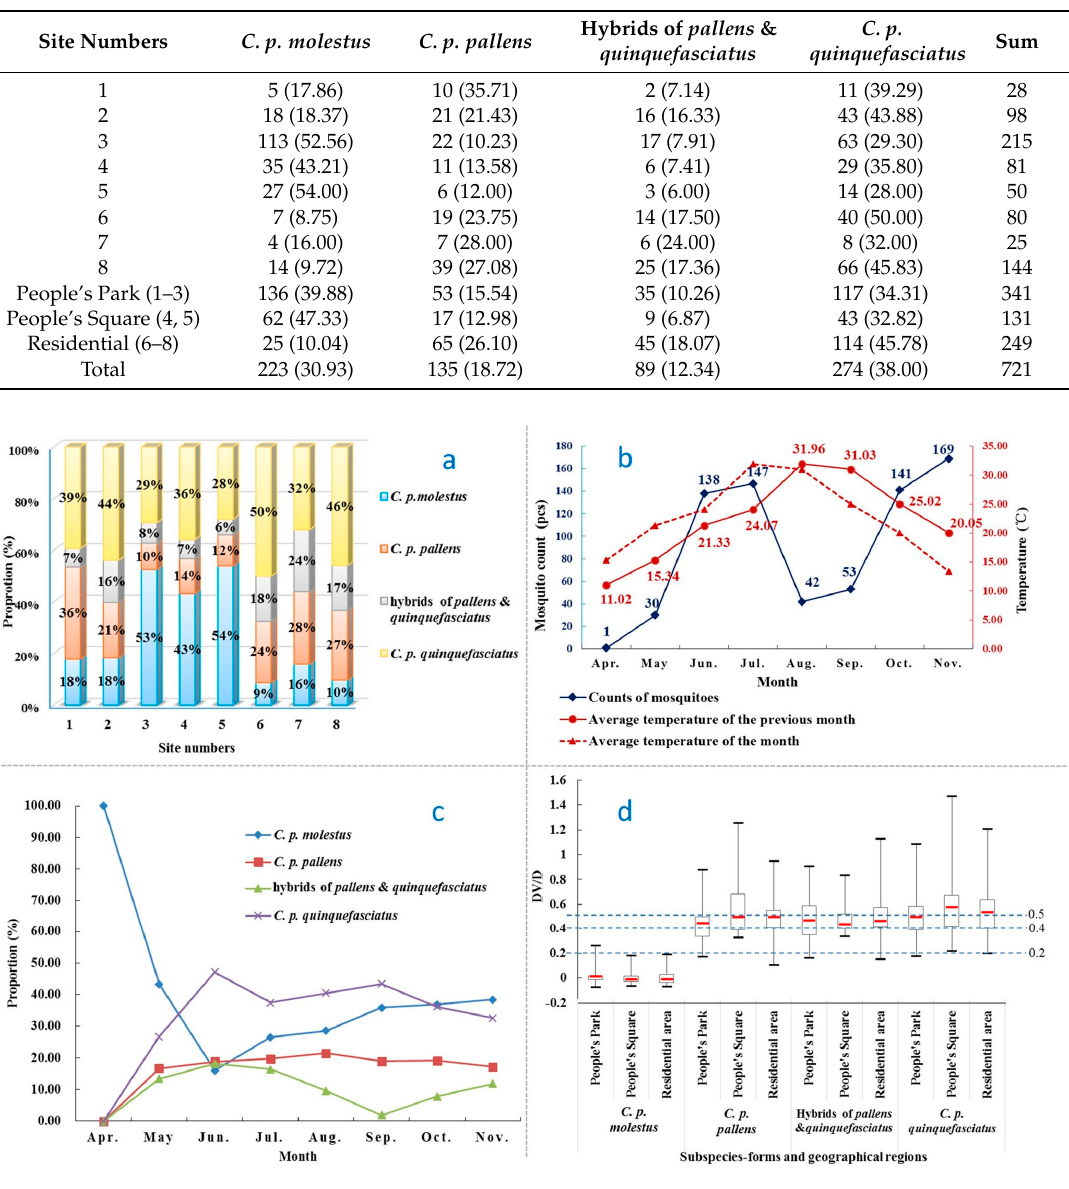
Figure 4. Characteristics of the structure, spatial and temporal distribution of Culex pipiens complex in downtown Shanghai, China. ( a ) Proportion of the four forms of Culex pipiens complex at the eight sites in downtown Shanghai; ( b ) Correlation between temperature and counts of Culex pipiens complex mosquitoes in downtown Shanghai; ( c ) Seasonal fluctuation of Culex pipiens complex members in downtown Shanghai; ( d ) DV/D ratio of Culex pipiens complex members in downtown Shanghai.